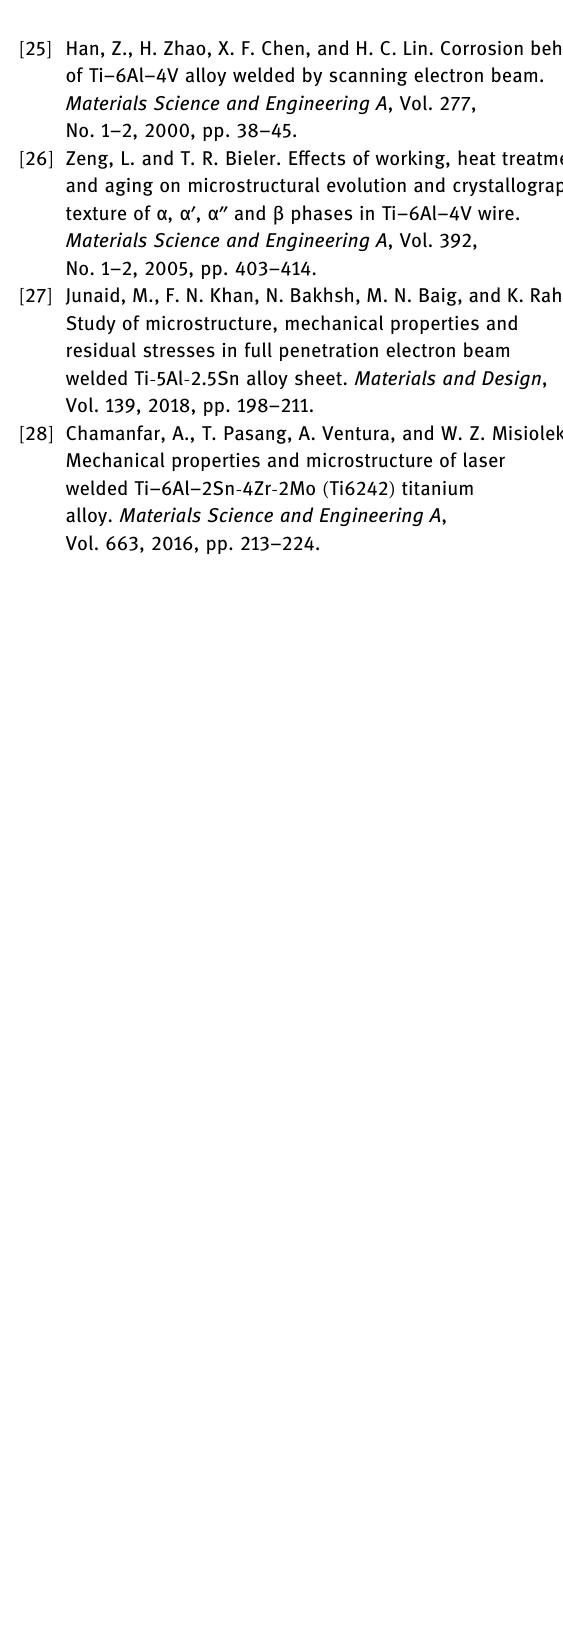
ff ect of di ff erent welding procedures on TA15 titanium alloy joint 